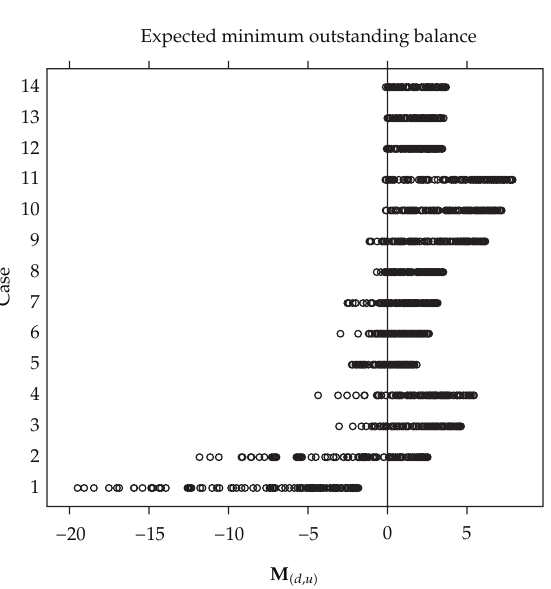
Figure 1: Range of approximate expected minimum outstanding balance M (cid:6) d,u (cid:7) values for all cases.